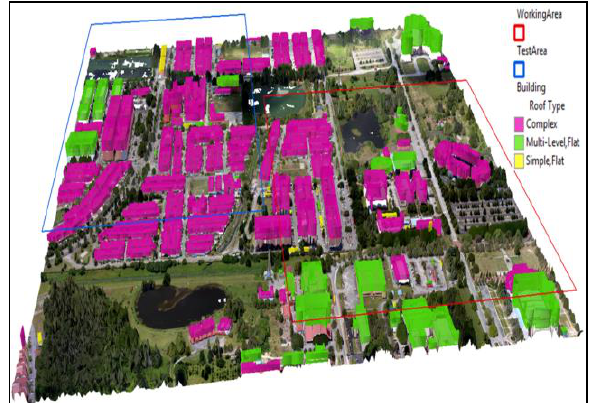
Figure 8. 3D model with classification based on building roof type.